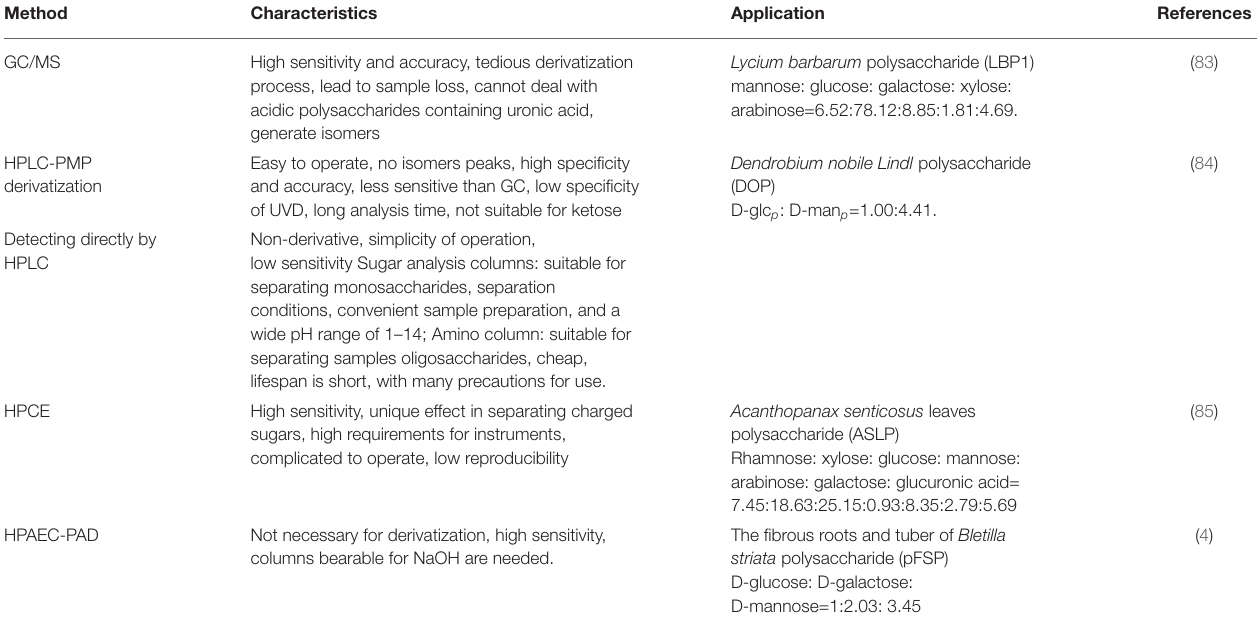
TABLE 2 | Comparison of determination methods of monosaccharide composition.